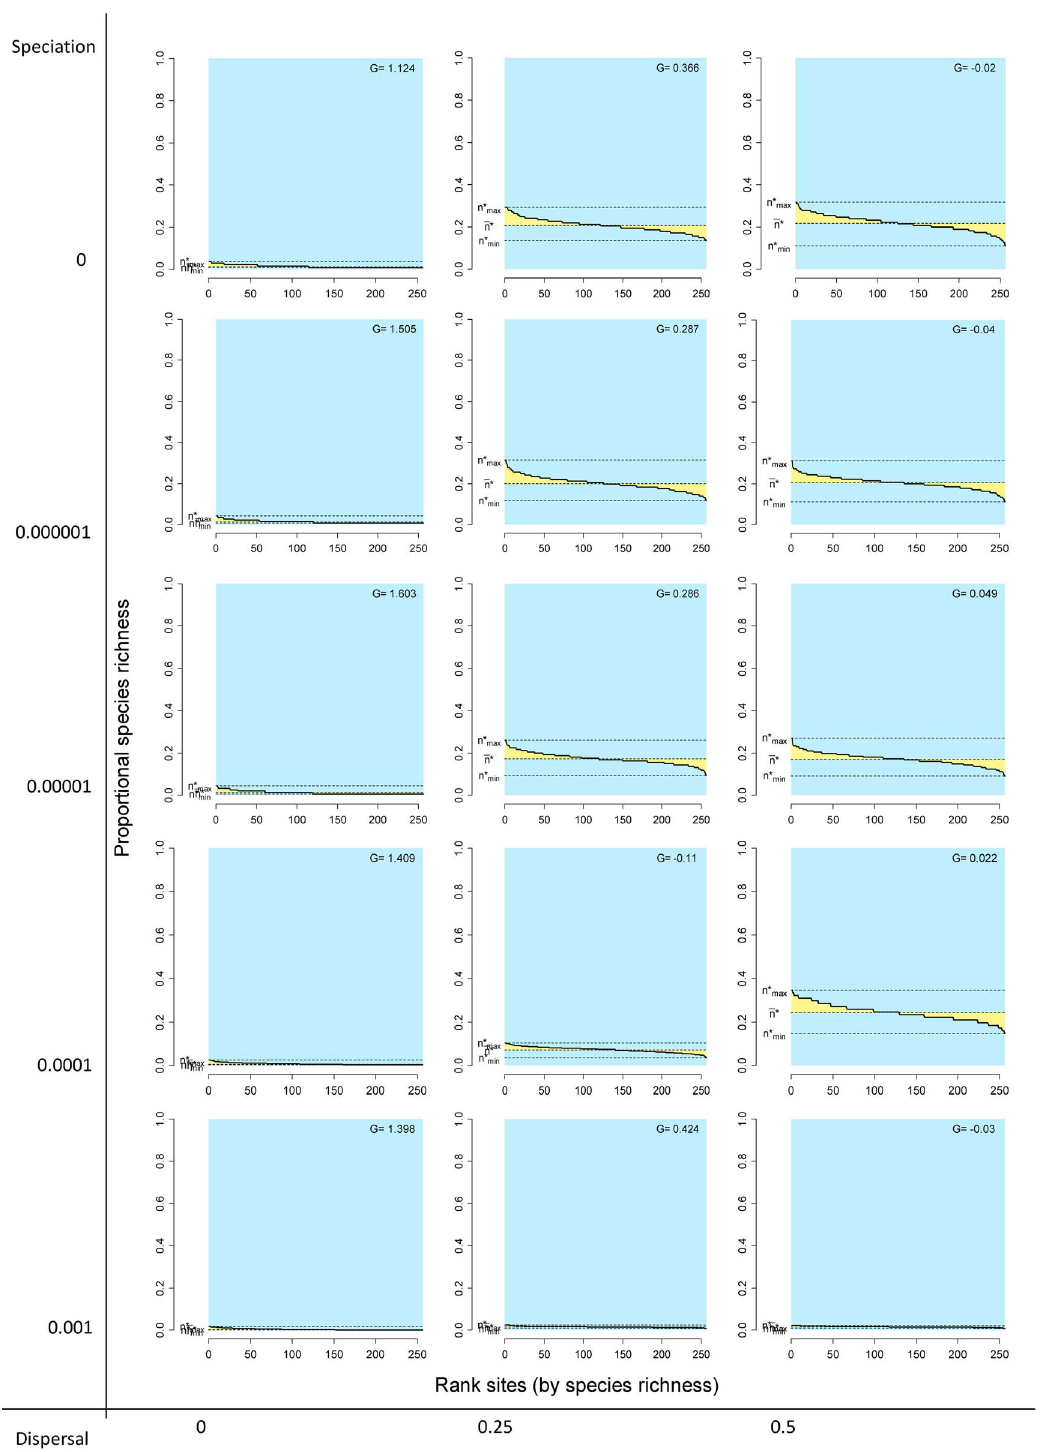
Figure 6. Rank diversity plots by sites for different combinations of the speciation and dispersal parameters in neutral models. Information as in Figures 1 and 2D.